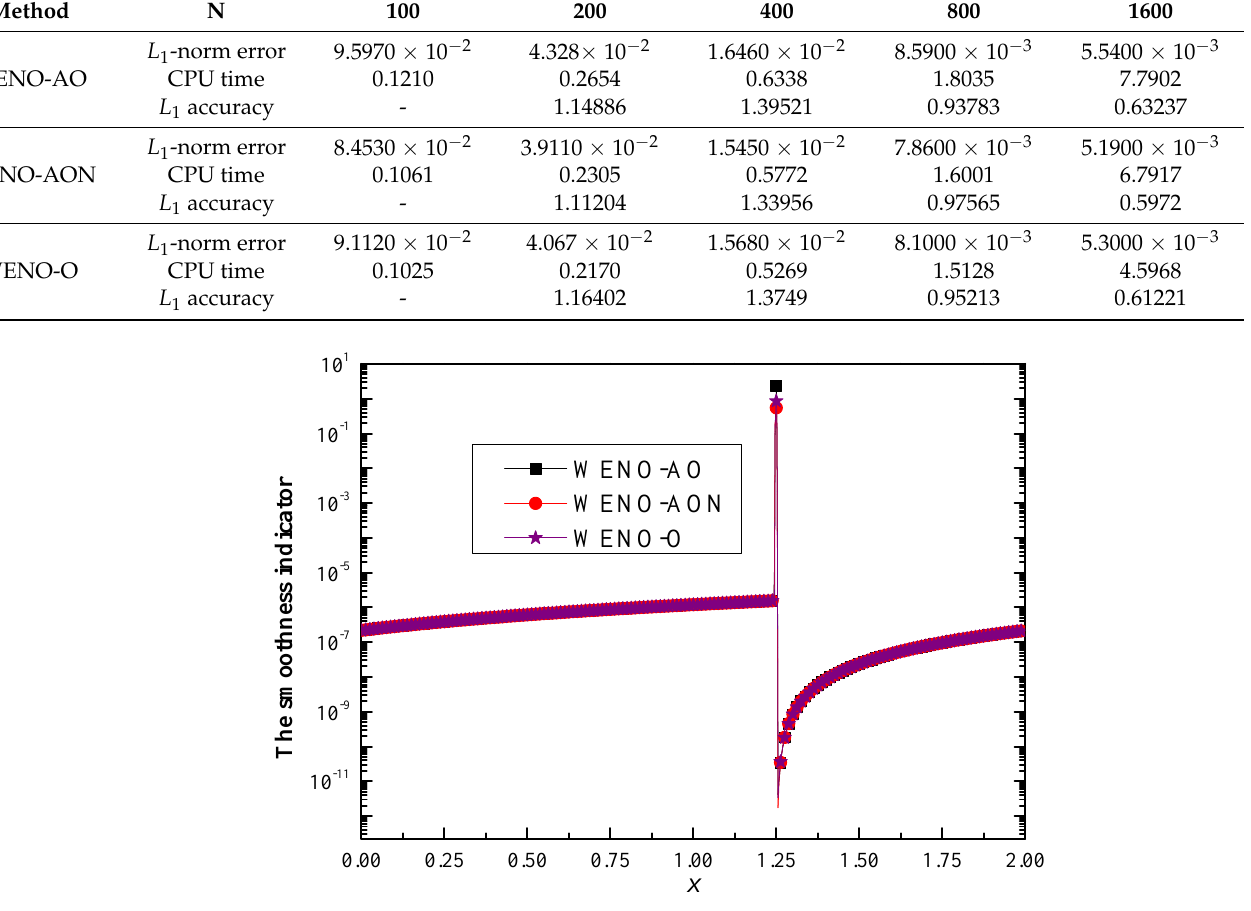
Figure 6. Comparison of smoothness indicators ¯ β h , β h , and ˆ β h of WENO-O, WENO-AO, and WENO- AON schemes, respectively, of Example 2 (Section